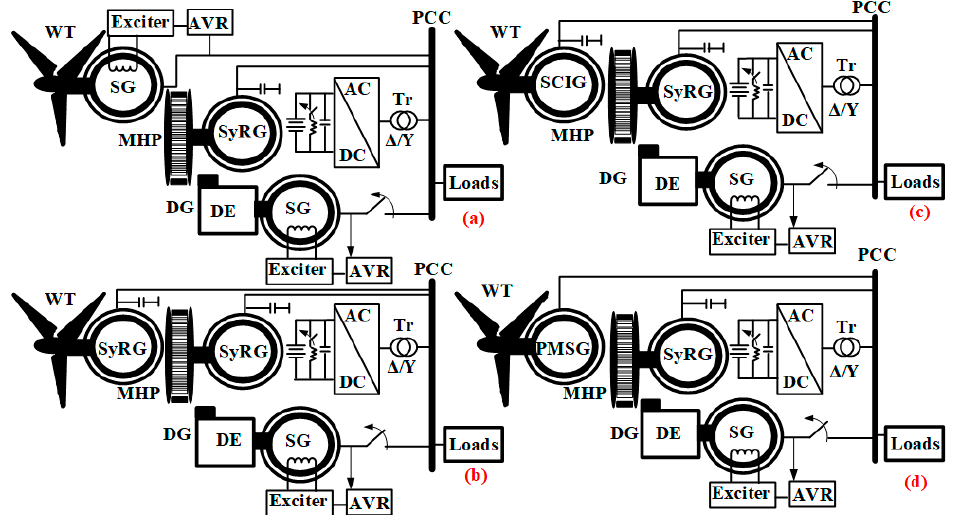
Figure 5. Off-grid configurations having MHP driven SyRG, DE driven SG and WT driven: ( a ) SG, ( b ) SyRG, ( c ) SCIG, and ( d ) PMSG.